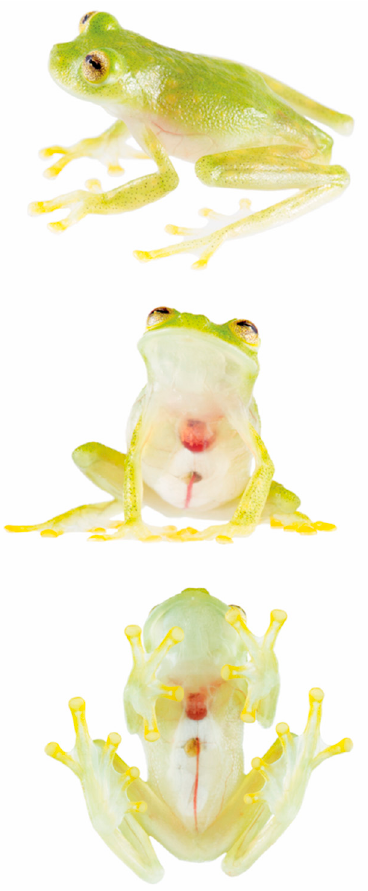
Figure 98. Hyalinobatrachium adespinosai in life, holotype, ZSFQ 1648. Photos by Jose Vieira / Tropical Herping.